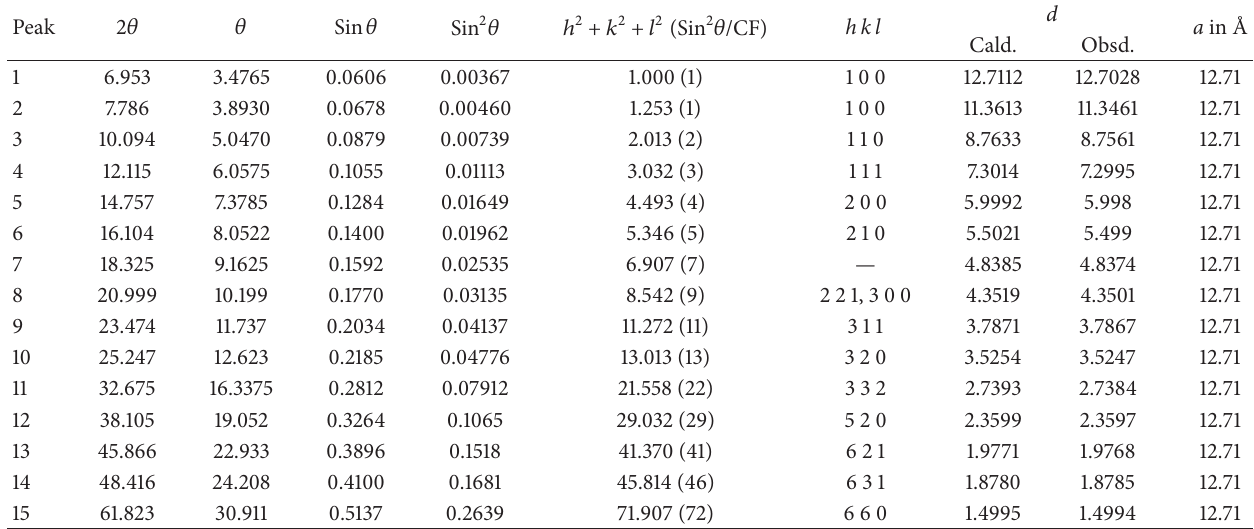
Table 7: Powder X-ray diffraction data of Zn(II) complex.